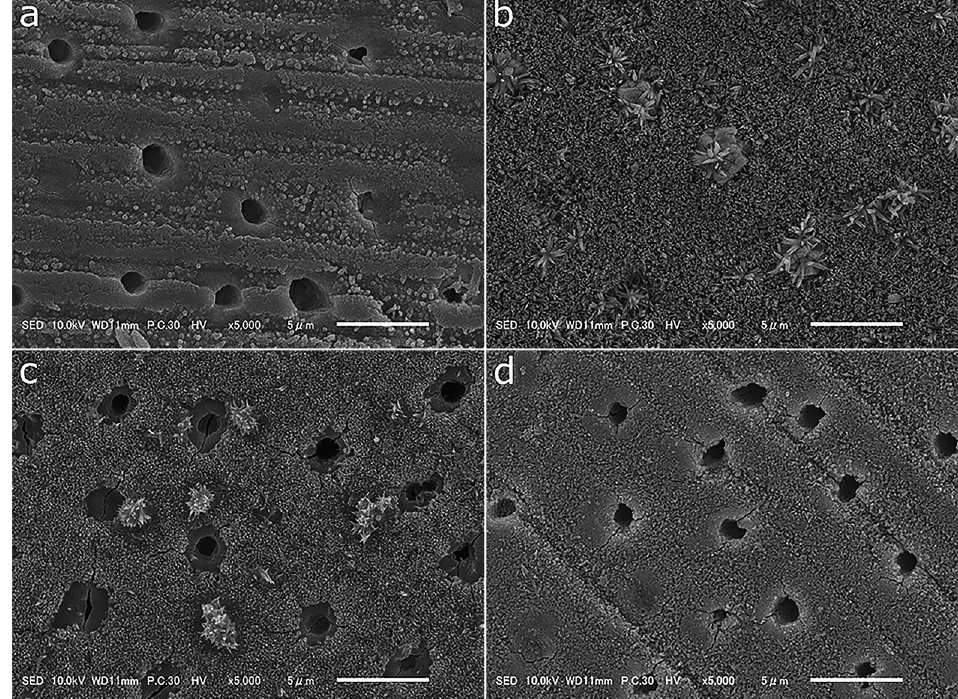
Figure 4- Topographical scanning electron microscopy images of flat dentinal surfaces treated with different solutions. (a) control, (b) 38% SDF followed by distilled water, (c) 38% SDF incor-porated with 20% GSH followed by distilled water, and (d) 38% SDF followed by 20% GSH